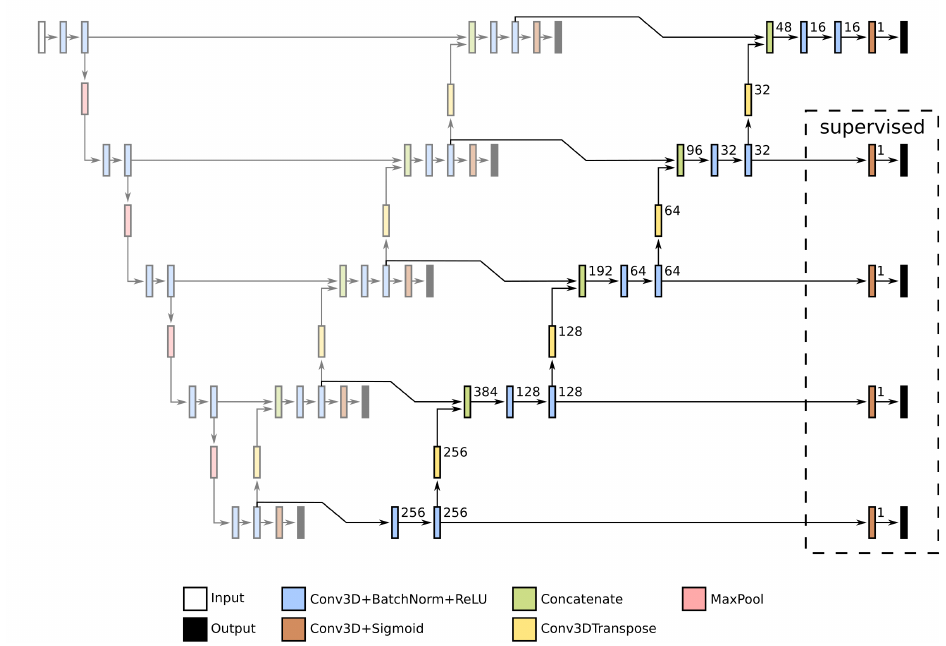
Figure 7. New layers of the second U-Net extension (EXT 2) with five scales, as used in our experi- ments. These layers (on the right) are connected with the basic U-Net (on the left), which is depicted without annotations. See Figure 6 for an explanation of the basic U-Net and used